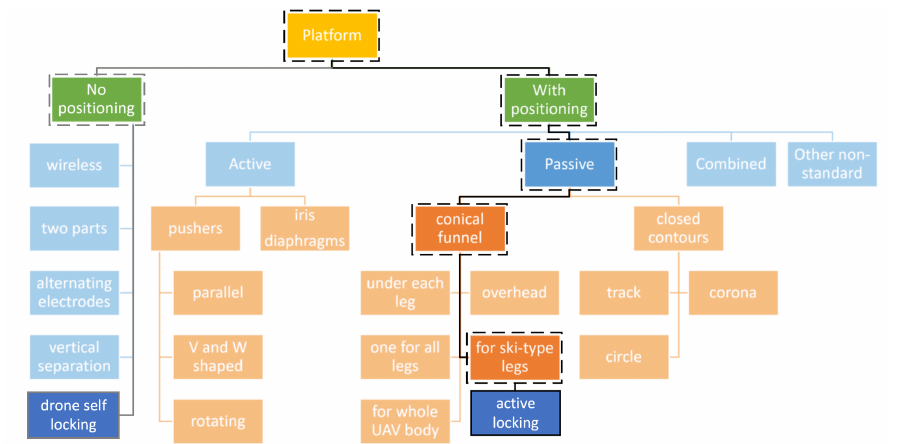
Figure 2. Place of drone landing platform with active locking and unlocking capabilities among existing